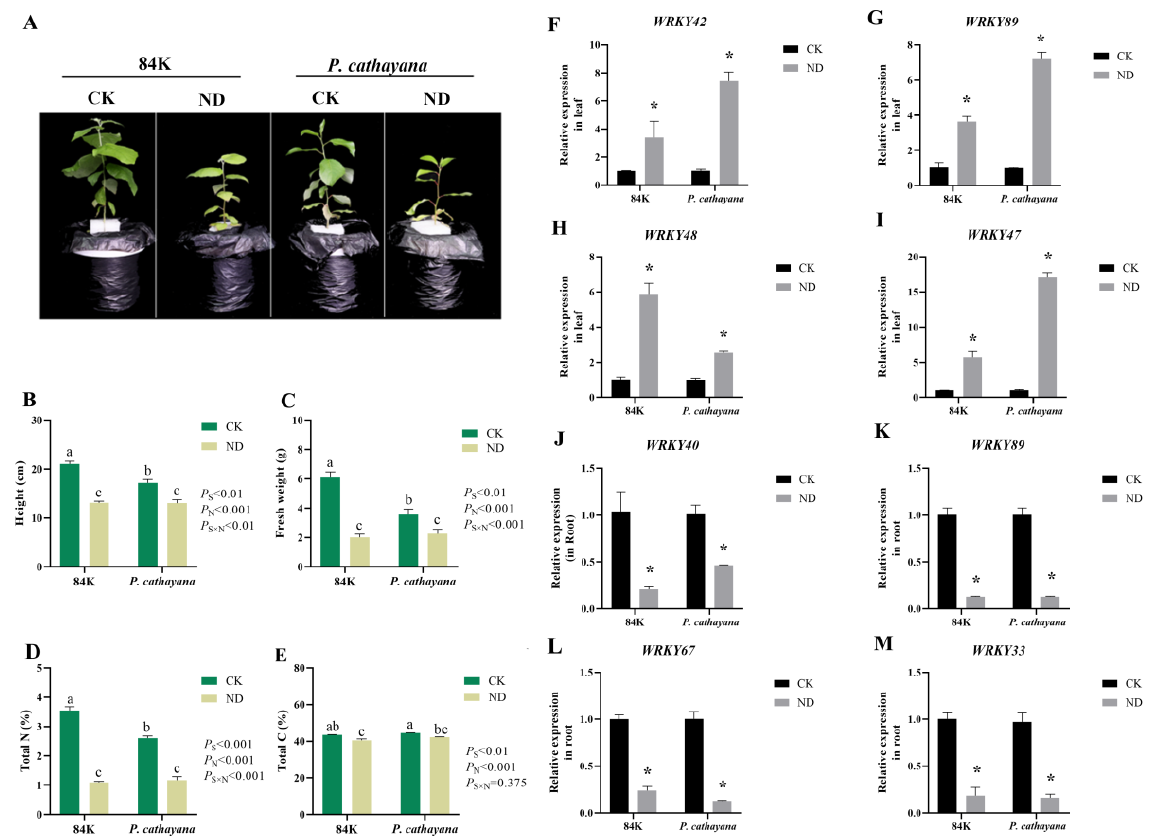
Figure 8. RT-qPCR analysis of PtWRKYs responding to nitrate. Growth inhibition of poplars treated after nitrogen deficiency ( A – E ). The relative expression levels of PtWRKYs in different poplar leaves ( F – I ) and roots ( J – M ) after nitrogen deficiency. CK, control group with normal nitrogen; ND, N- deficiency treatment group. Each set had three biological replicates and showed the mean ± standard error. According to the ANOVA analysis of the Turkey test, different letters indicate significant differences ( p ≤ 0.05). According to independent sample t -test results, “*” indicated significant difference in gene expression compared with control (CK) ( p ≤